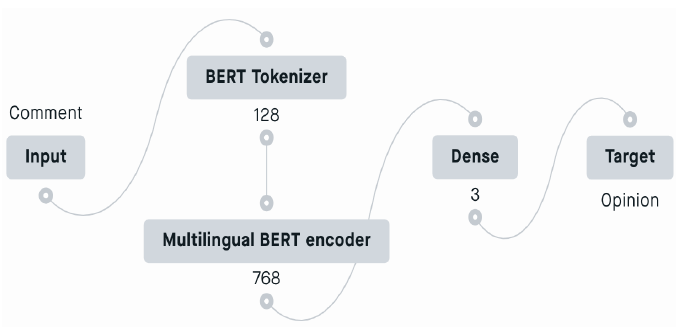
Figure 9. Sentiment classifier using mBERT.